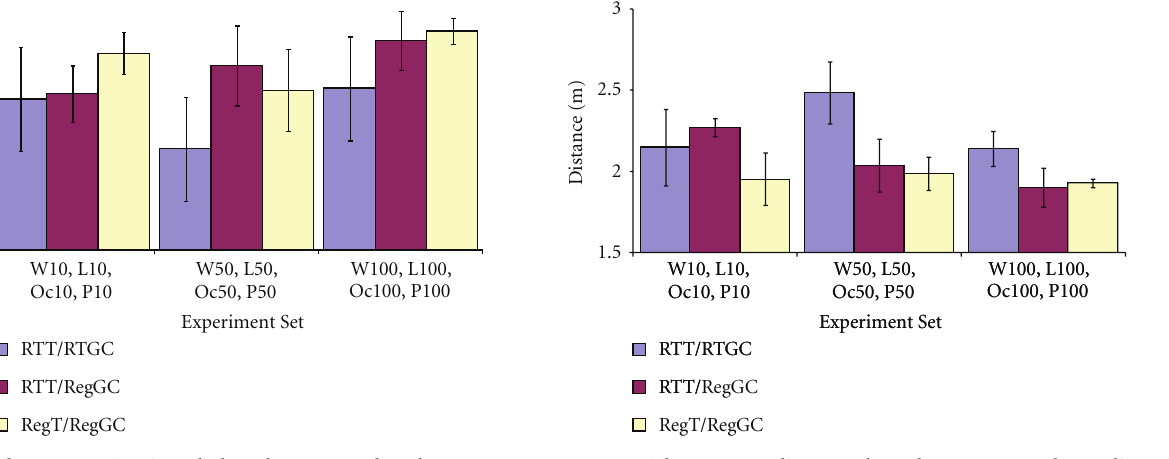
Figure 5: The average time it took the robot to complete the course for group 1.